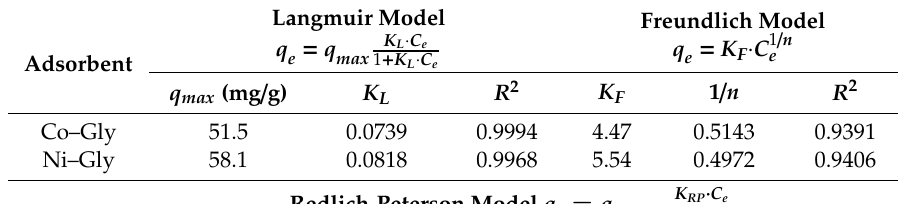
Figure 5. Equilibrium of Cd(II) adsorption onto: ( a ) Co–Gly and ( b ) Ni–Gly. Table 3. Equilibrium adsorption isotherm parameters for Cd